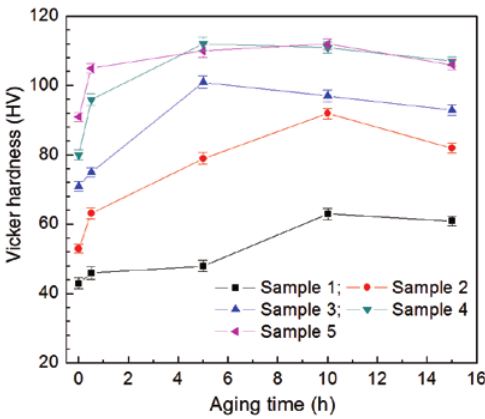
Figure 3: Aging-hardness curves of the samples aging at 175 ° C.